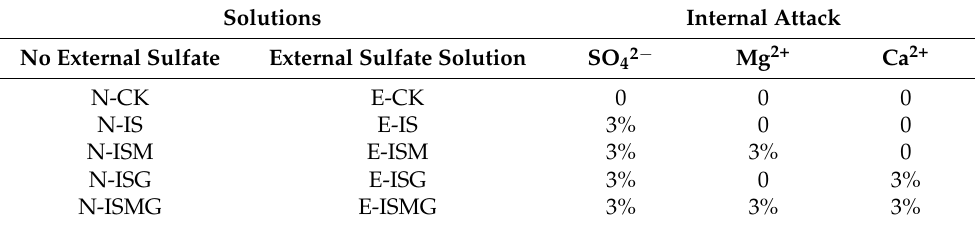
Table 4. Information on specimens and corrosion